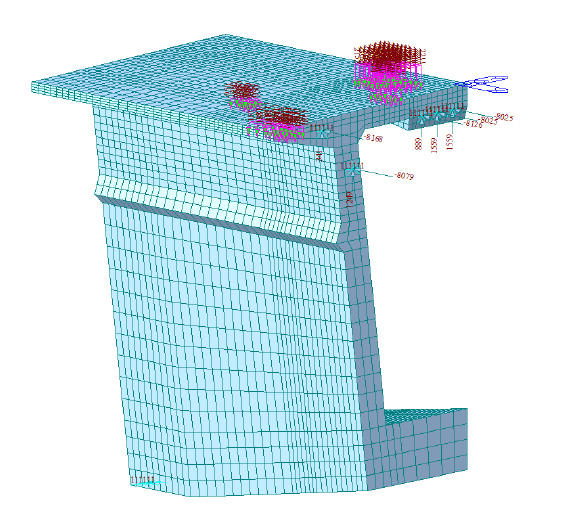
Figure 7. D model of cast-in situ pier elements.